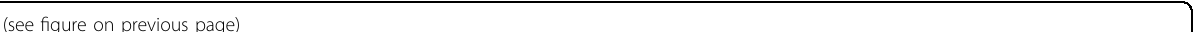
Fig. 5 Effect of G-CSF on myeloid cells. a UMAP visualization of nine subclusters of the myeloid lineage across two donors. b Dot plot showing the average expression of cell type-associated marker genes in myeloid subclusters and percentage of cells expressing these genes. c Bar plot displaying changes in the percentage of myeloid subclusters before and after G-CSF treatment. d Volcano plot showing the DEGs of myeloid cells in G-BM compared with unstimulated BM. DEGs were detected by differential expression analysis (two-sided Student ’ s t -test). Each dot represents a single gene. Genes with logFC < − 0.25 and logFC > 0.25 were selected and colored in blue and red, respectively. e Heatmap showing scaled expression of top 15 DEGs in CD14 + monocytes before and after G-CSF treatment. f Metascape bar graph showing functional enrichment of downregulated genes in CD14 + monocytes after G-CSF treatment. Enrichment terms sorted by − log 10 ( P value) were displayed by bars with a discrete color scale representing statistical signi fi cance. The top 20 enriched terms are displayed. g Heatmap showing scaled expression of top DEGs in CD16 + monocytes after G-CSF treatment. h Metascape bar graph showing functional enrichment of upregulated genes in CD16 + monocytes after G-CSF treatment. Enrichment terms sorted by − log 10 ( P value) were displayed by bars with a discrete color scale representing statistical signi fi cance. The top 20 enriched terms are shown. i Dot plot showing average expression of genes related to IL-4 signaling pathway in CD16 + monocytes before and after G-CSF treatment and the percentage of cells expressing these genes. Representative upregulated DEGs enriched in the IL-4 signaling pathway in h are displayed. j Violin plot showing scores of the M-MDSC signatures before and after G-CSF administration in monocyte subclusters. AddModuleScore function in Seurat R package was used to calculate the average expression with default settings. * P value < 0.05; **** P value <